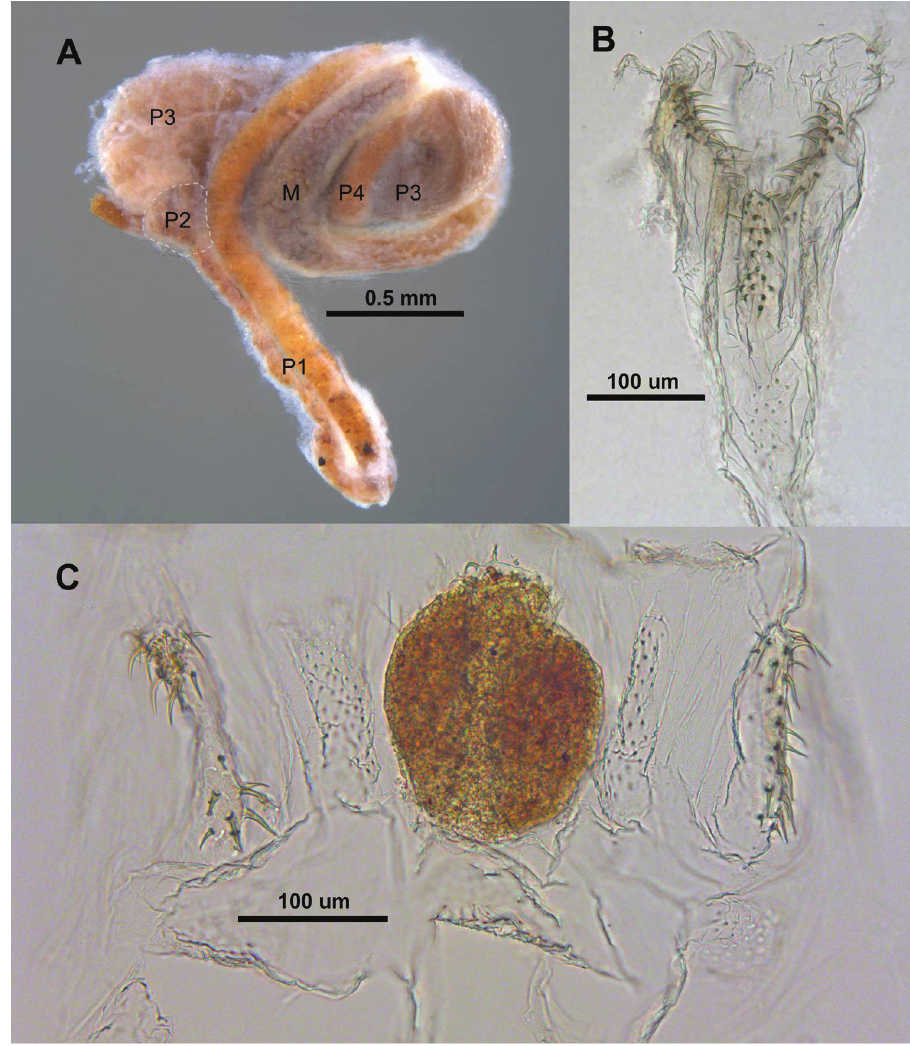
Figure 1. Parvitermes brooksi . A Dorsal left view of gut: M = mesenteron, P1-P4 = proctodeal segments 1-4 (limits of P2 highlighted) B Whole mount of P2 with musculature removed. Posterior (end attached to P3) at top of image C P2 splayed open; bacterial pellet attached to spines of the central pad.